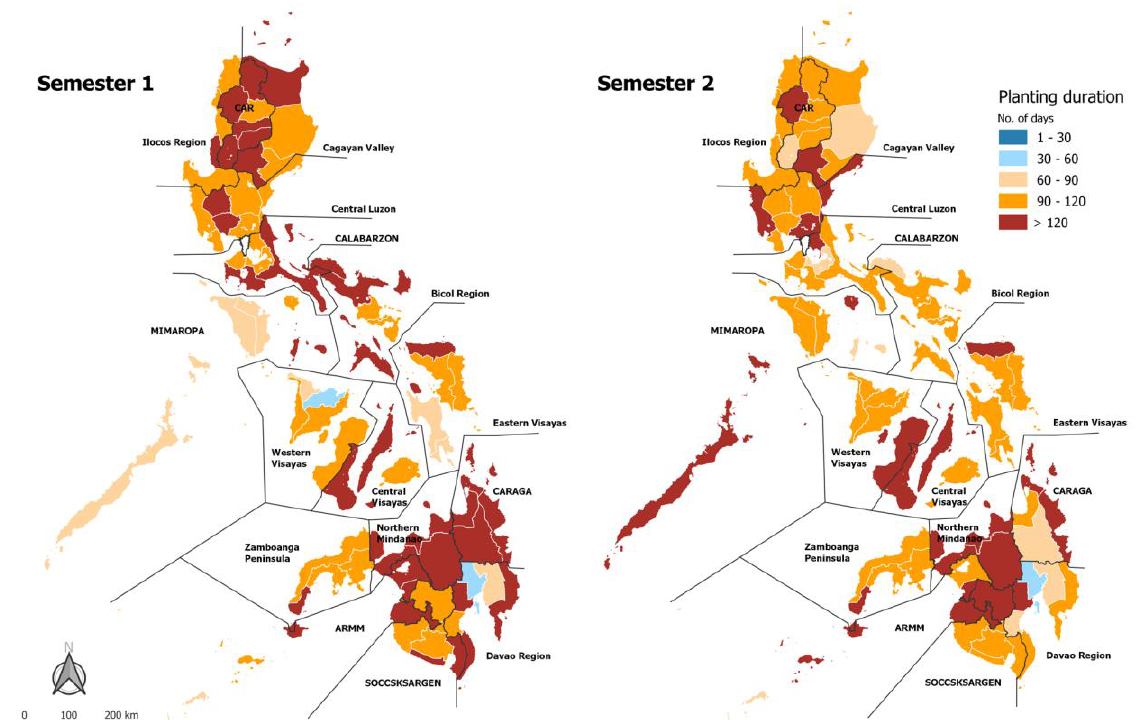
Figure 7. Duration of planting dates (in days) by semester and province in the Philippines,